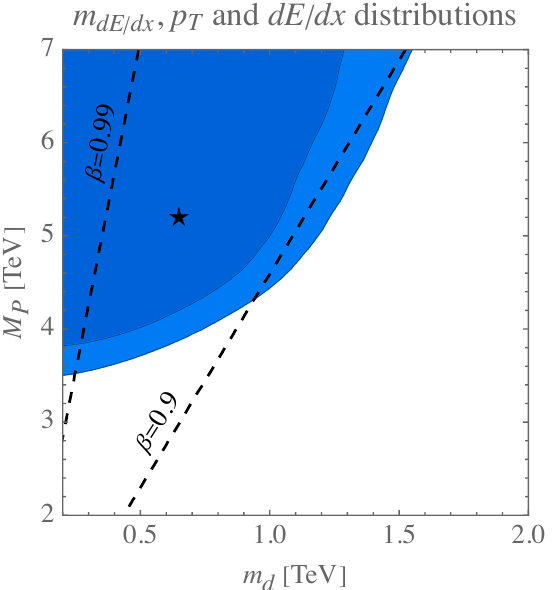
Figure 3 . Profile-likelihood fit of the m , p T and dE/dx distributions. Contours show the dE/dx 1 σ and 2 σ preferred regions. The star indicates the best-fit point located at M P = 5 . 2 TeV and m d = 650 GeV . The dashed lines denote the corresponding values of β for a decay at rest of the parent